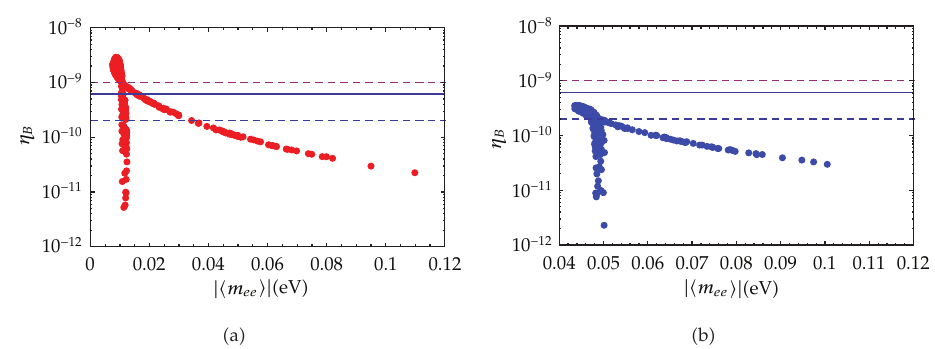
Figure 8: Prediction of η B as a function of |(cid:2) m ee (cid:3)| or the NH case (cid:2) a (cid:3) and IH case (cid:2) b (cid:3) . The horizontal solid and dashed lines correspond to the experimental central value and phenomenologically allowed